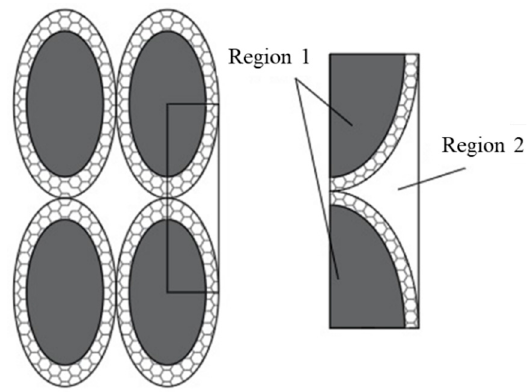
Figure A2. Configurations of equivalent particles aggregated.